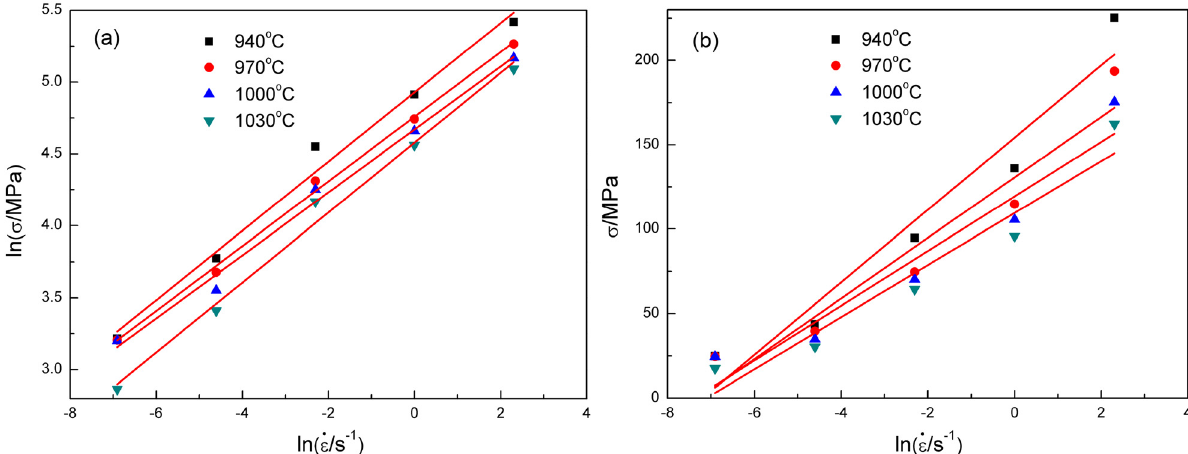
Figure 3: Linear regression analysis for the plots of: ( a ) ln σ − ln ε ̇ and ( b ) σ − ln ε ̇ .